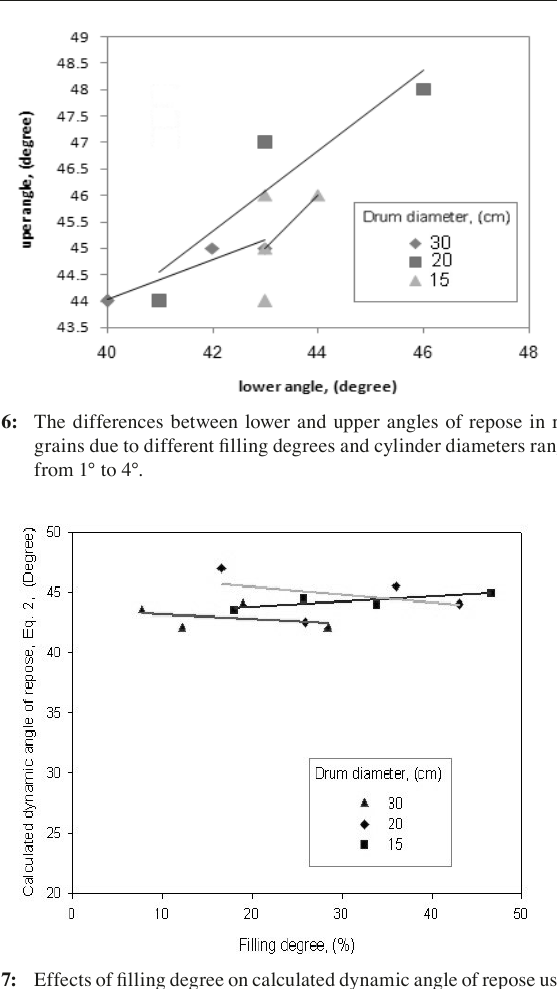
Fig. 7: Effects of filling degree on calculated dynamic angle of repose using Eq. (5) for cylinders with diameters equal to 15, 20, and 30 cm. Tab. 2: Dynamic angle of repose obtained by three different methods. Method